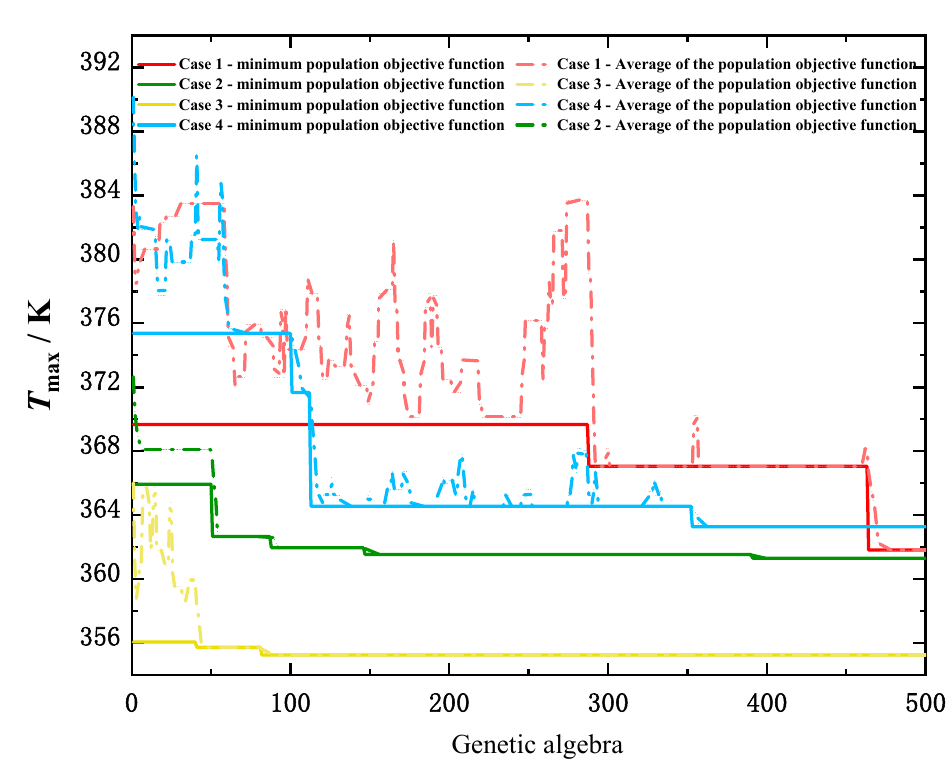
Table 2. Chip operating conditions.